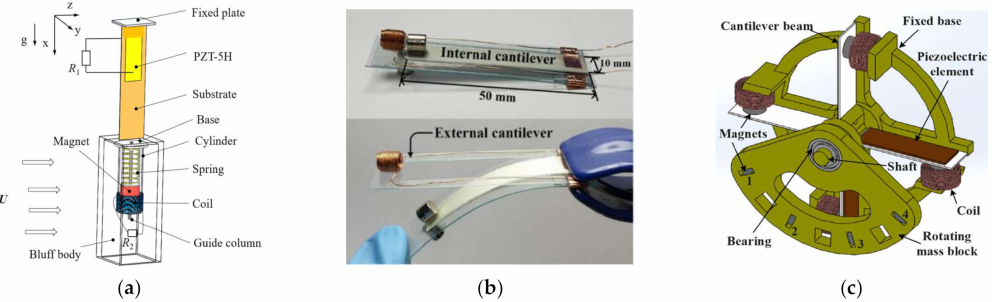
Figure 1. Various structures of energy harvester: ( a ) a piezoelectric–electromagnetic energy harvester with internally placed coils; ( b ) a piezoelectric–electromagnetic hybrid energy harvester based on frequency up-conversion; ( c ) a multimodal piezoelectric–electromagnetic hybrid energy